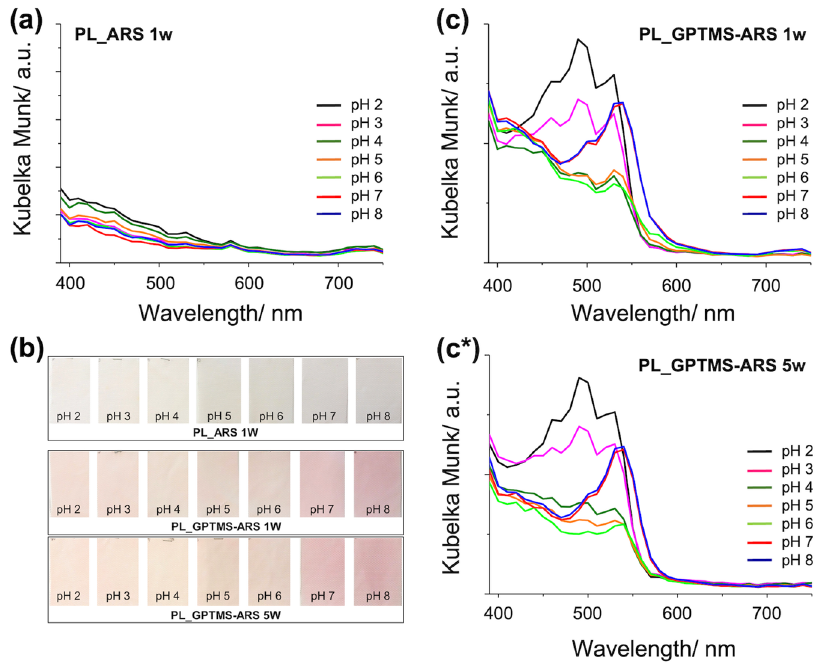
Figure 4. Kubelka–Munk spectra of polyester fabric treated with plain ARS after 1 wash ( a ), with GPTMS-ARS after 1 and 5 washing cycles ( c and c* , respectively) at different pH values. Images of PL_ARS and PL_GPTMS-ARS after 1 and 5 washing cycles ( b ).